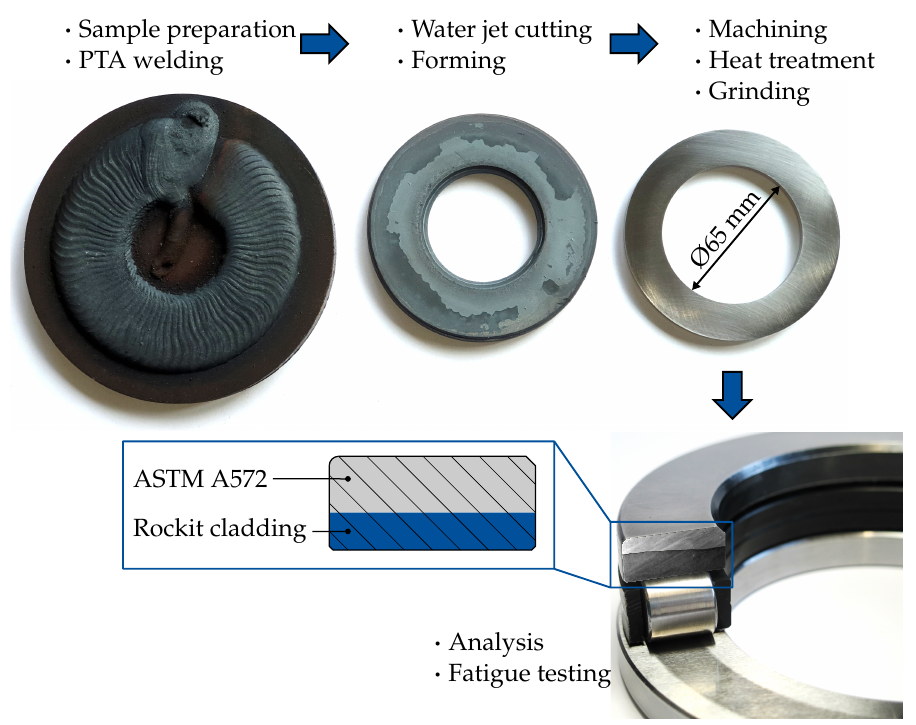
Figure 1. Workflow for Tailored Forming of bearing